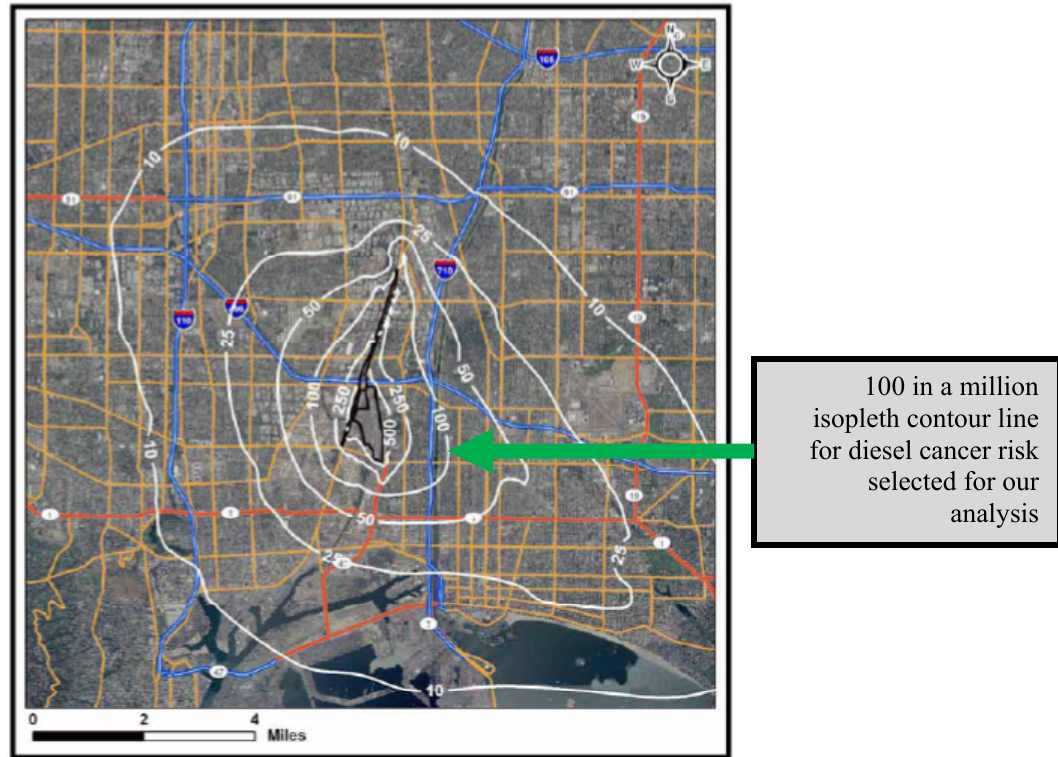
* Reproduced with permission of the California Air Resources Board.